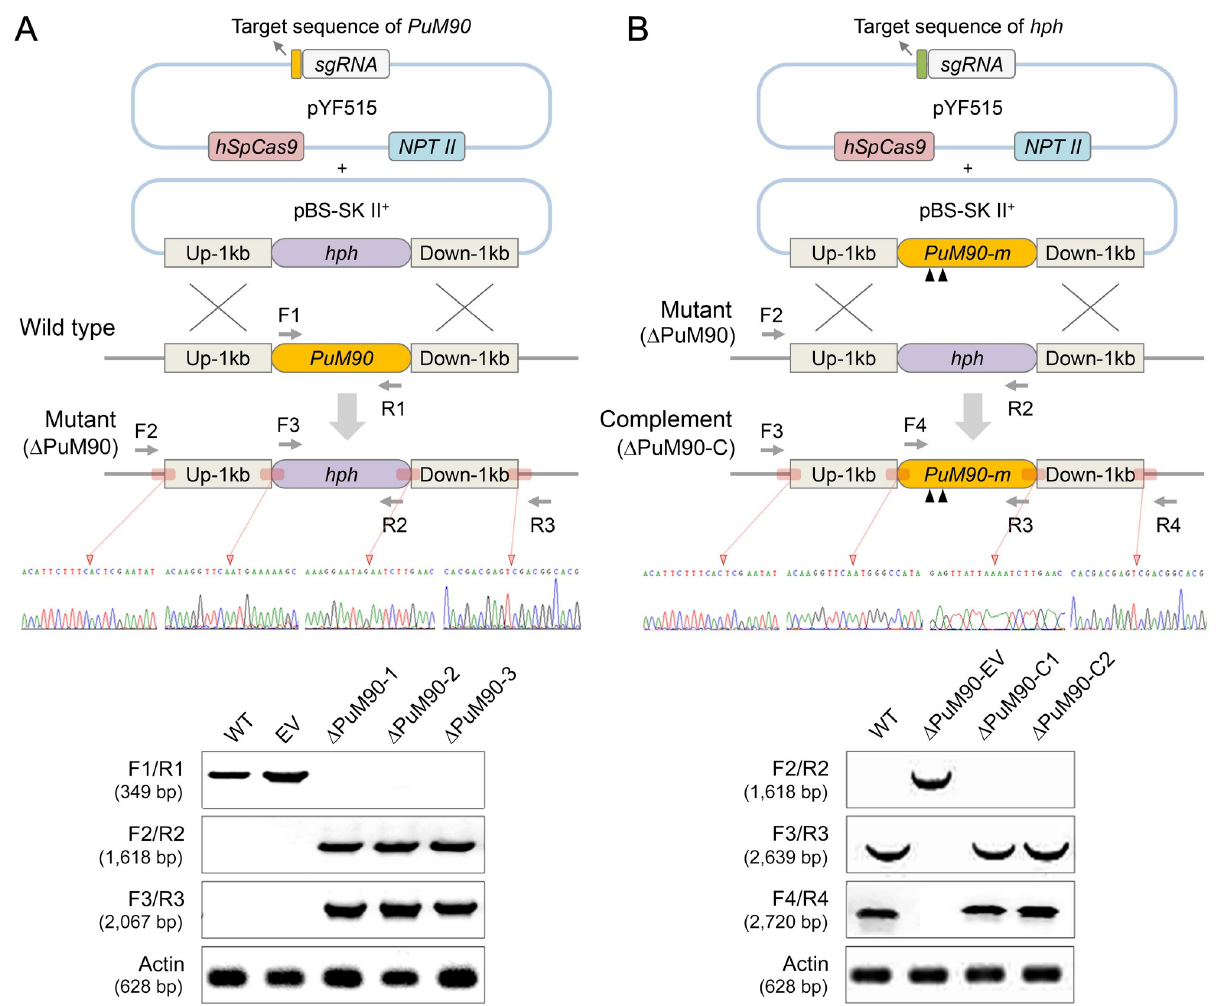
Fig 2. CRISPR/Cas9-mediated PuM90 gene knockout and complementation. (A) Schematic diagram of homology-directed repair-mediated modification of the target gene. Top: an ‘all-in-one’ plasmid (pYF515) harboring both Cas9 and sgRNA cassettes was co-transformed with a plasmid (pBS-SK II + ) containing homologous donor DNA hph with PuM90 flanking sequences. Locations of the primers used to screen the HRR mutants and Sanger sequencing traces of junction regions confirming that the PuM90 ORF was precisely replaced. Bottom: analysis of genomic DNA from the wild- type (WT), empty-vector control line (EV), and PuM90 -knockout mutants ( Δ PuM90-1/2/3) using the primers shown at the top and actin primers as a positive control. (B) Schematic representation of the Δ PuM90 mutant complementation strategy and the plasmids used for second transformation in Pythium . Top: PuM90-m with two black triangles indicates PuM90 modified with two sgRNA targeting sequences. Locations of the primers used to screen the complementation mutants and Sanger sequencing traces of junction regions confirming that the PuM90 ORF was precisely complemented. Bottom: analysis of genomic DNA from the wild-type (WT), complemented transformants ( Δ PuM90-C1/2), and empty control line of Δ PuM90 ( Δ PuM90-EV) using the primers shown at the top and actin primers as a positive control.